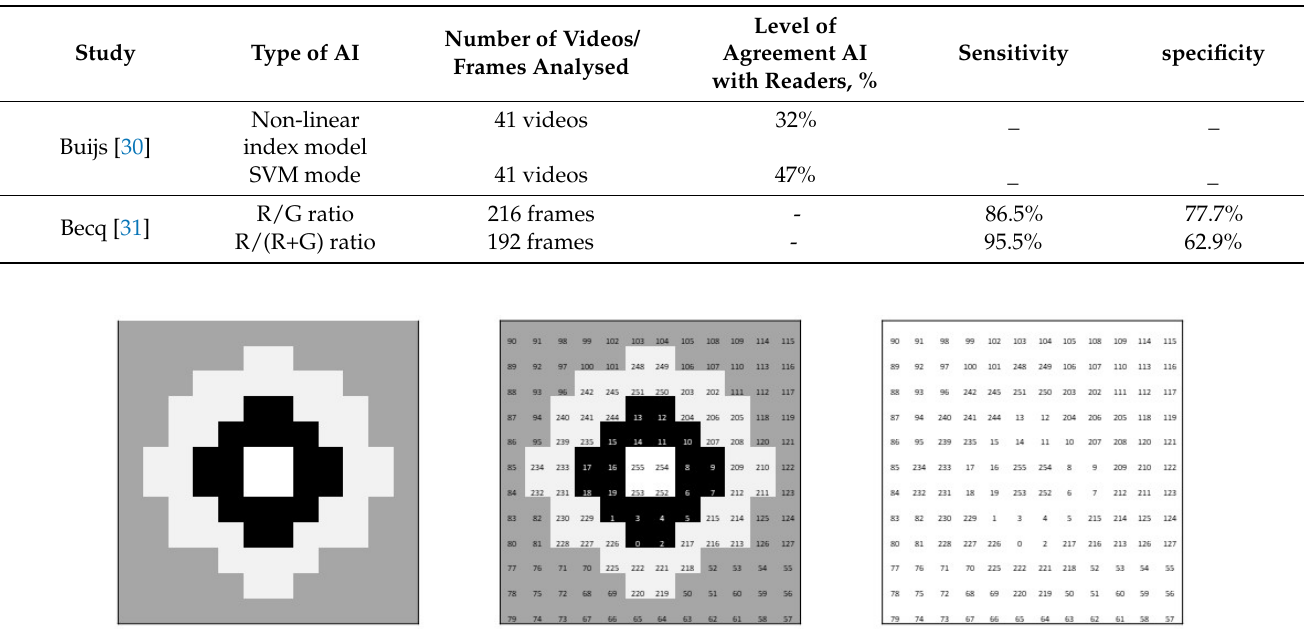
Figure A1. An example of mapping locations in the images to the pixel value as part of machine analysis of the picture.